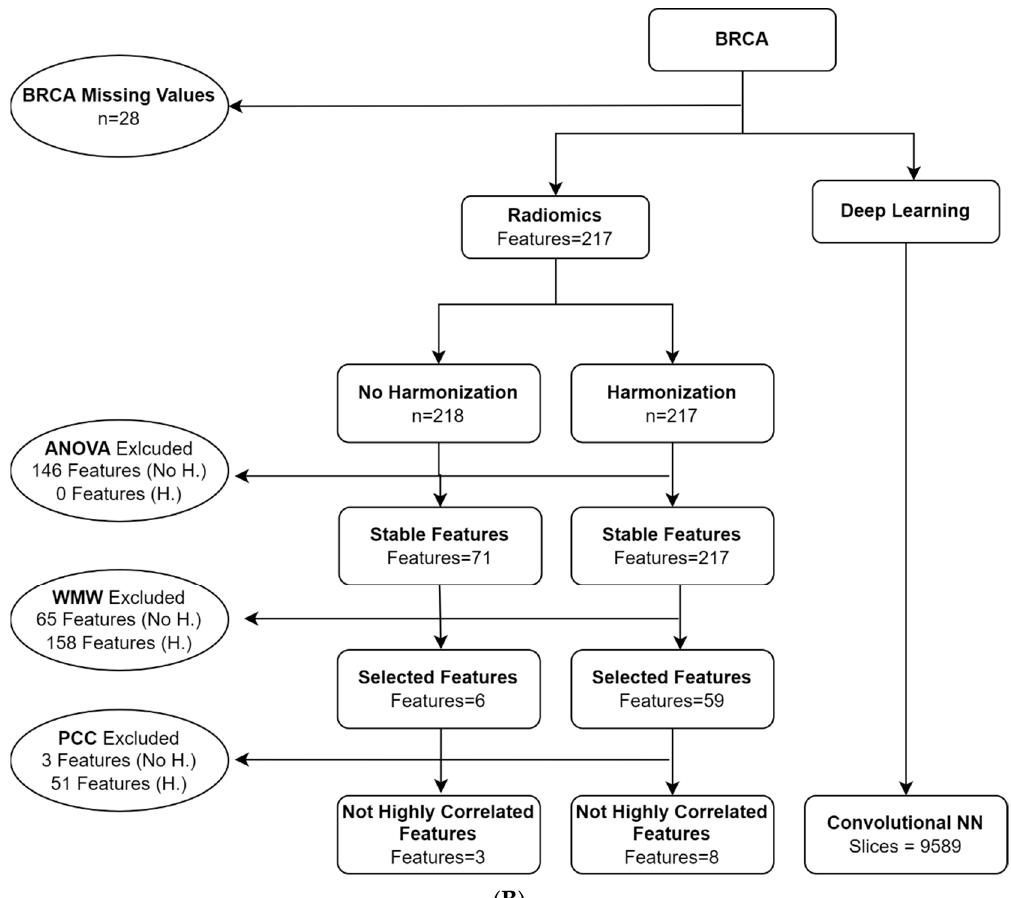
Figure 2. ( A ) Flowchart of the patients and features selections for relapse ( n = number of patients; Features = number of features; slices = number of included slices; WMW: Wilcoxon–Mann–Whitney; PCC: Pearson cross-correlation; NN: neural network). ( B ) Flowchart of the patients and features selections for BRCA mutation ( n = number of patients; Features = number of features; slices = number of included slices; WMW: Wilcoxon–Mann–Whitney; PCC: Pearson cross correlation; NN: neural network) .